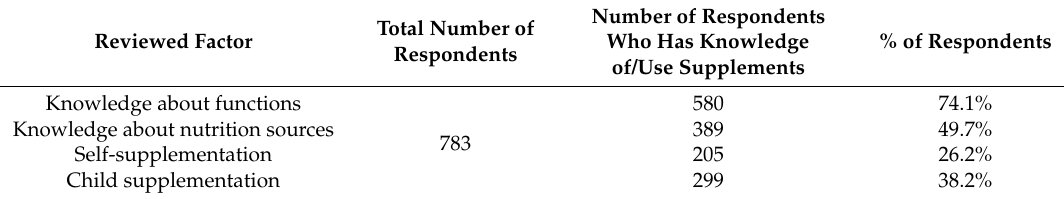
Table 2. Knowledge about vitamin D function, nutrition sources and its supplementation popularity among respondents ( n = 783).